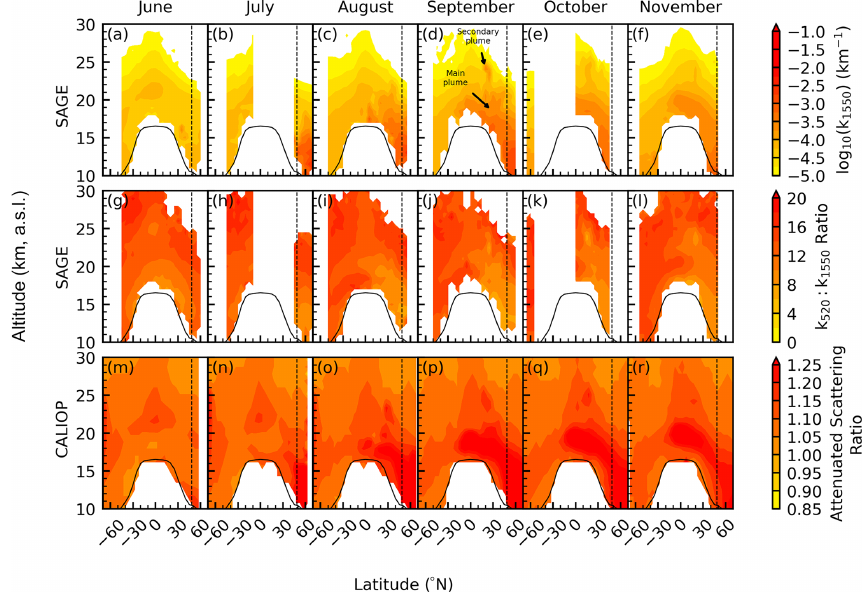
Figure 13. Zonal monthly mean of 1550nm extinction coefficients (a–f) , 520 : 1550 extinction ratio (g–l) , and attenuated scattering ratio from CALIOP (m–r) . The solid black line indicates the average tropopause altitude, and the dashed black line indicates Raikoke’s